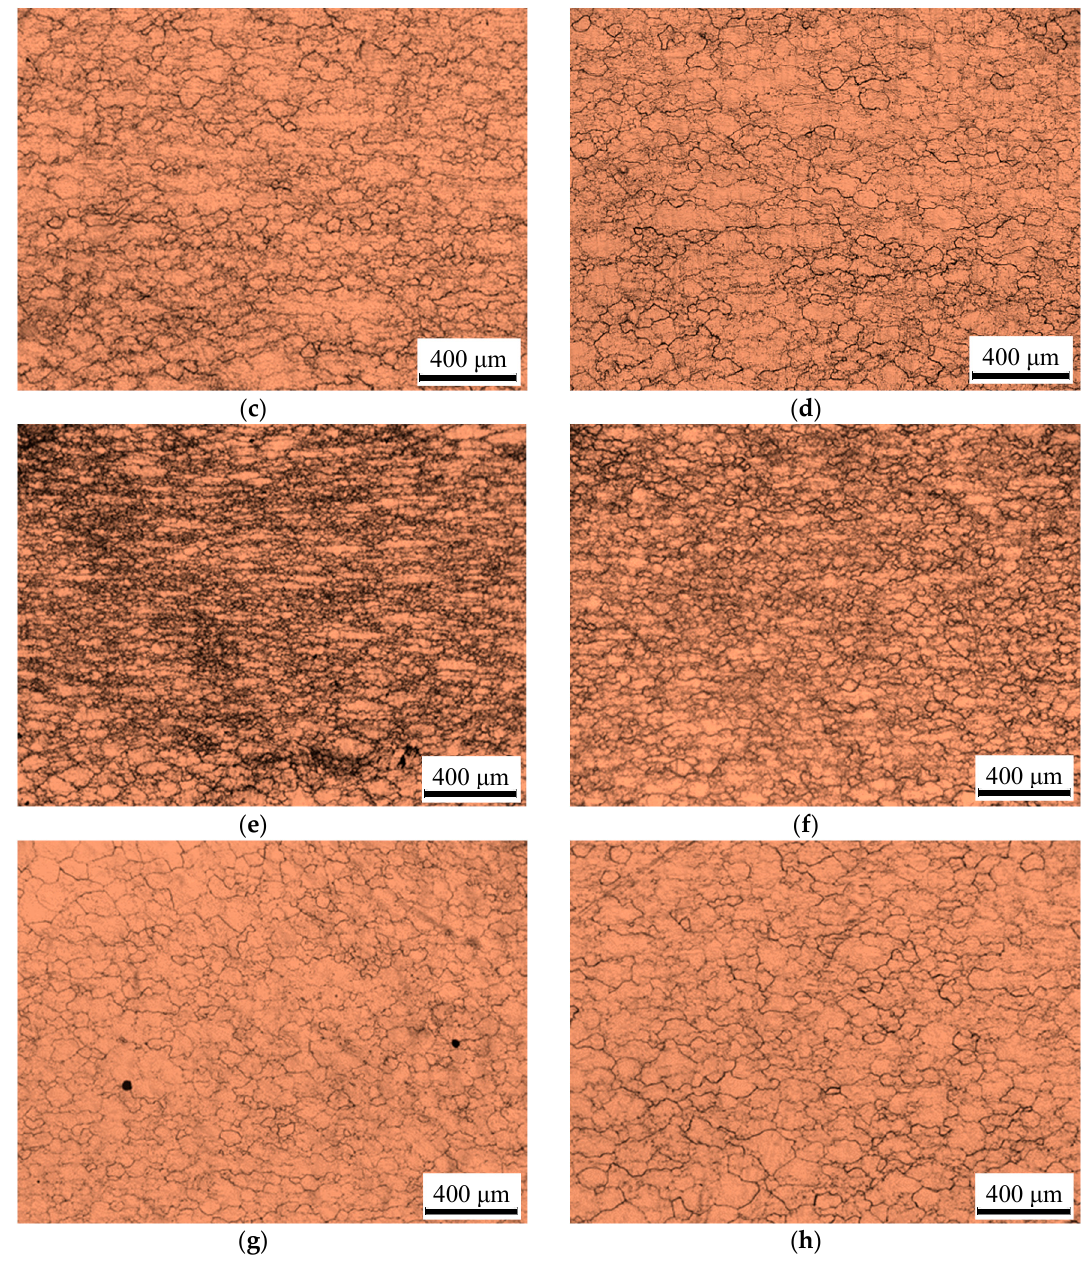
Figure 13. Optical microstructures of the coarse-grained ( a – d ) and fine-grained ( e – h ) alloys in the stability region at a strain of 0.8 and deformation conditions of (( a ) and ( e )) 850 °C/10 − 3 s − 1 , (( b ) and ( f )) 900 °C/10 -3 s -1 , (( c ) and ( g )) 950 °C/10 − 3 s − 1 , and (( d ) and ( h )) 1000 °C/10 − 3 s − 1 .